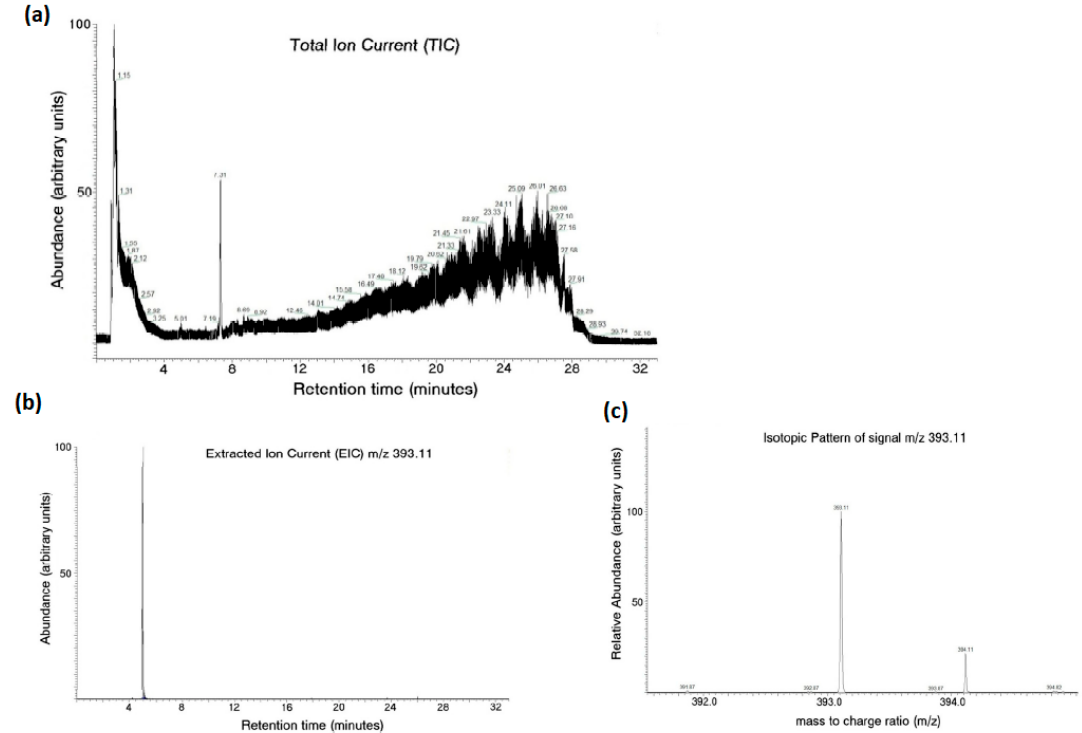
Figure 3. Aloesin content in the aqueous media after the release of therapeutic lens incubation measured with LC–MS analysis. The total ion current from the analysis revealed the complexity of the examined mixture ( a ). Aloesin was identified by the extracted ion current ( b ) and isotopic pattern analysis ( c ) using an m / z of